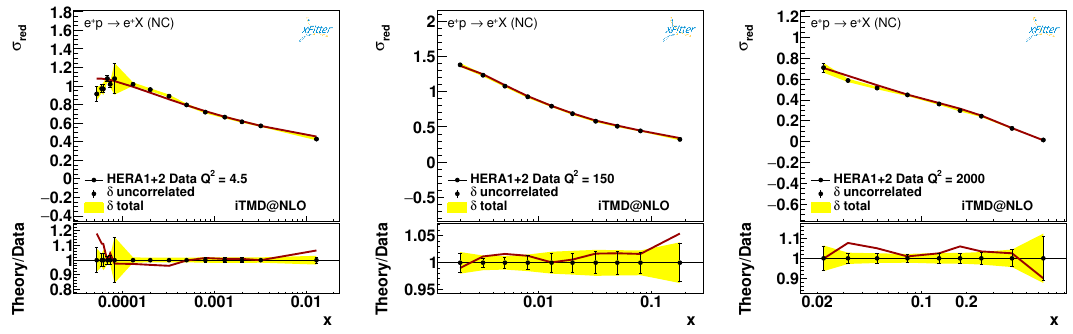
Figure 5 . The reduced cross section (cid:27) red as measured at HERA compared to the NLO (cid:12)ts from the parton branching method (red line) for di(cid:11)erent values of Q 2 , obtained using